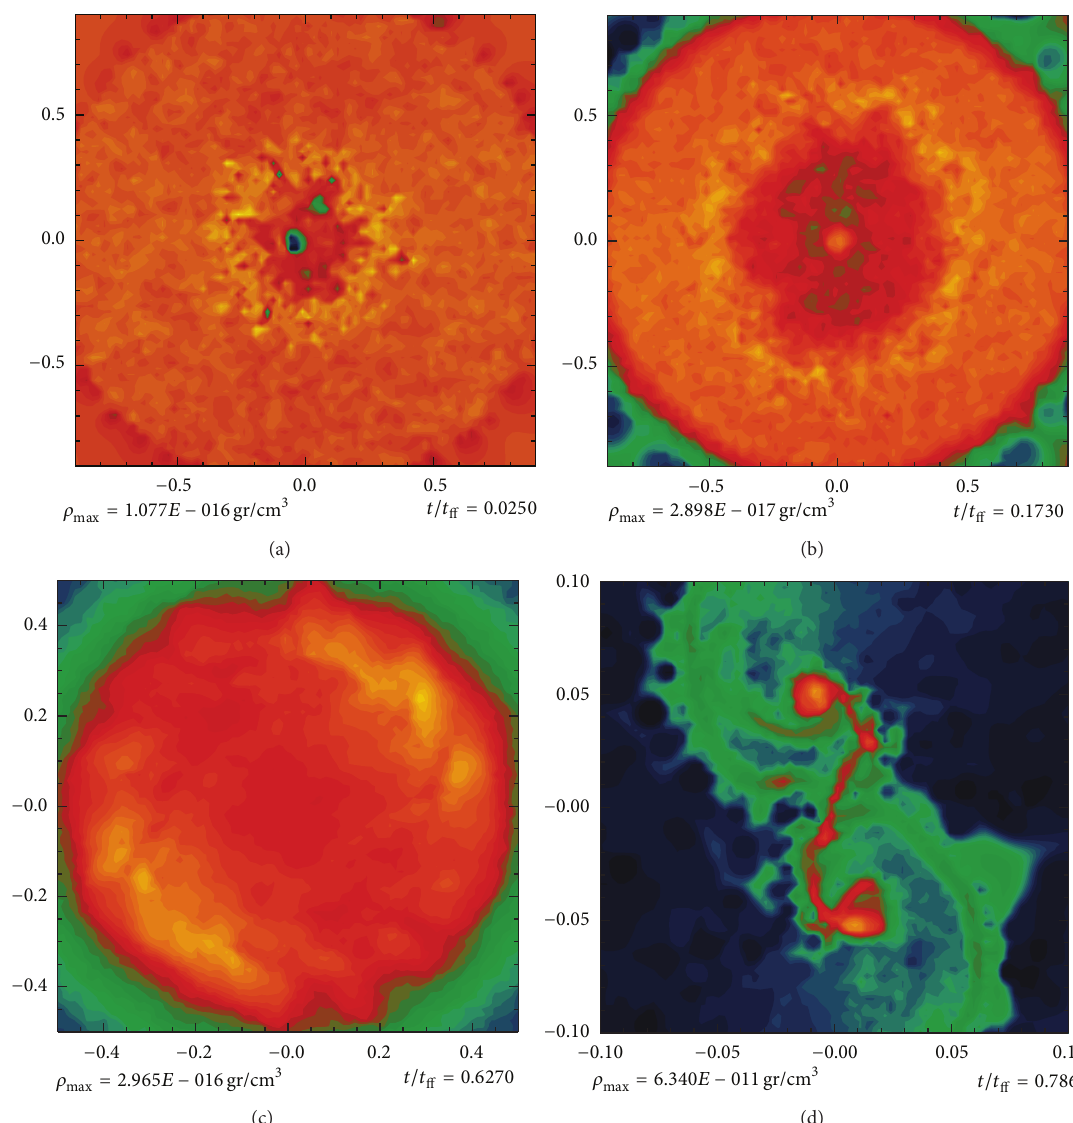
Figure 13: Iso-density plots for a thin slice of matter parallel to 𝑥𝑦 plane for the collapse of the rotating core with wind particles rotating with = 1000 × Ω Ω 𝑤 𝑐